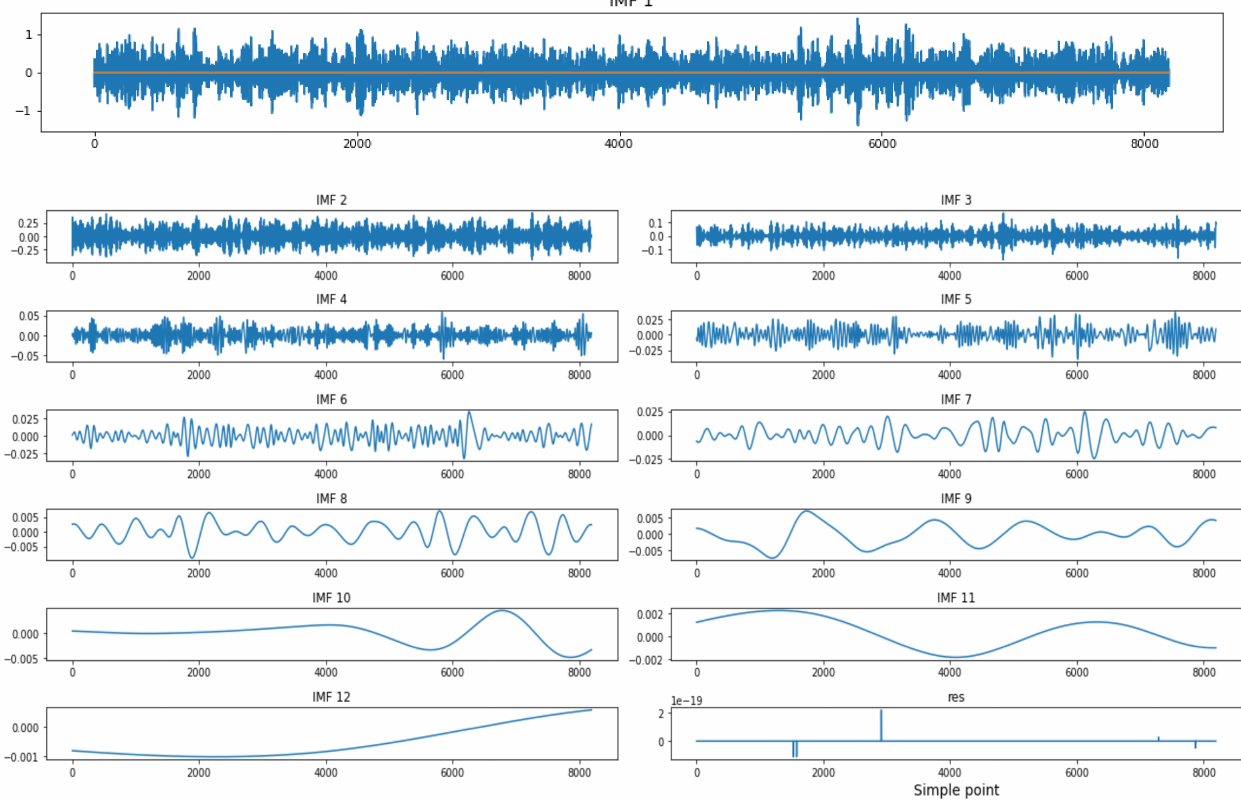
Figure 12. Results of decomposition for A_4 acceleration data